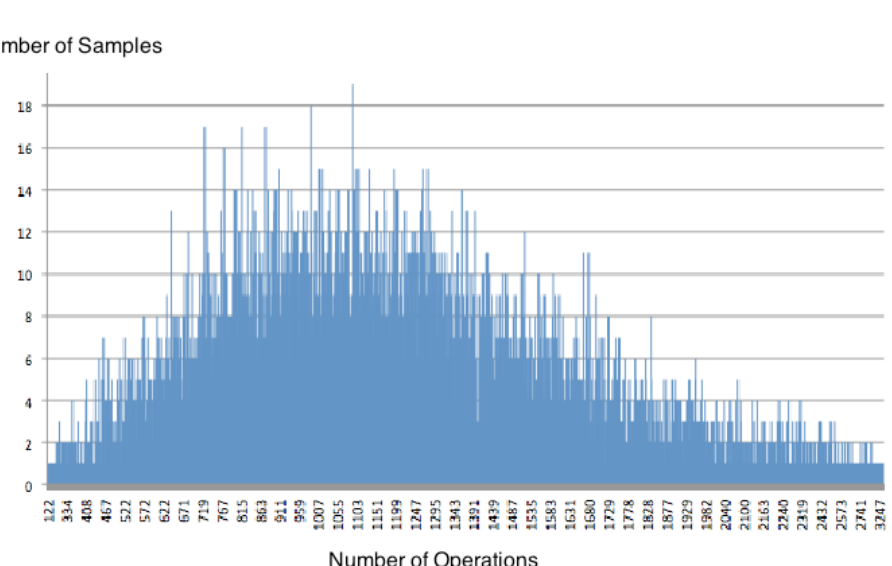
Figure 5. Distribution for n = 100 and m = 700 , m